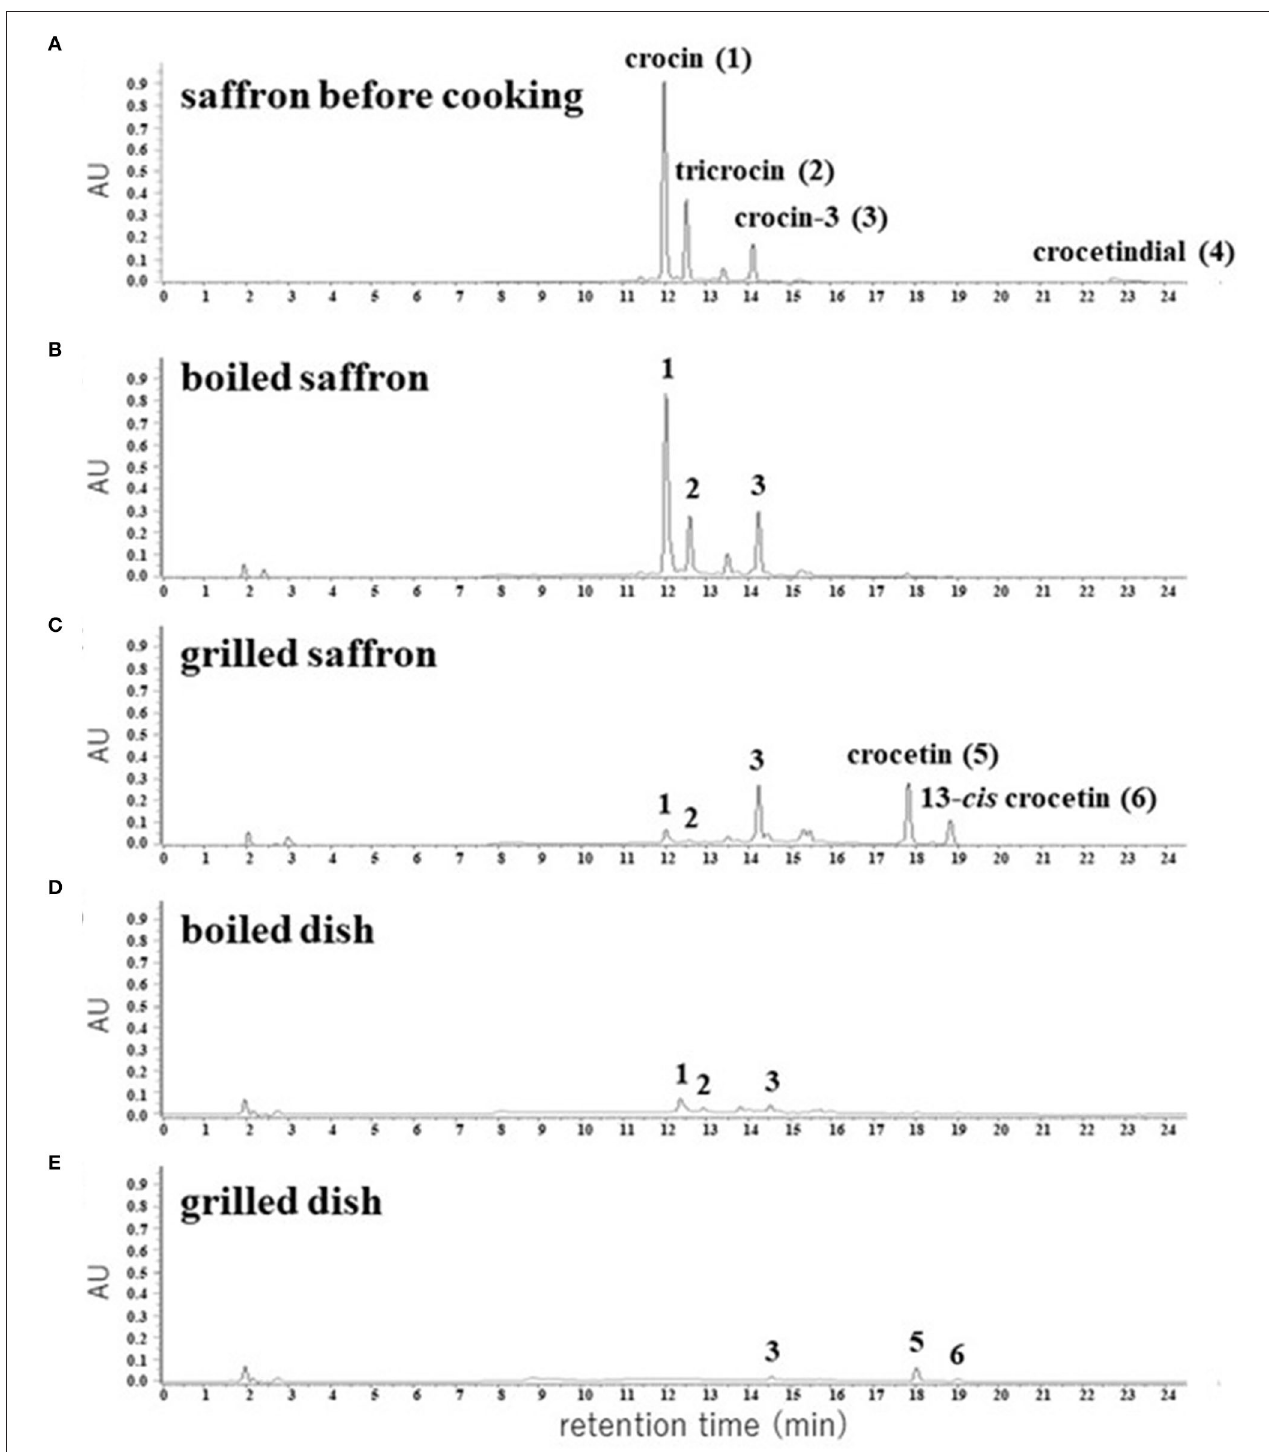
FIGURE 4 | HPLC chromatograms of apocarotenoids extracted from the dried pistils of saffron (A) and their cooked materials (B–E) . The detection wavelength was 440 nm.